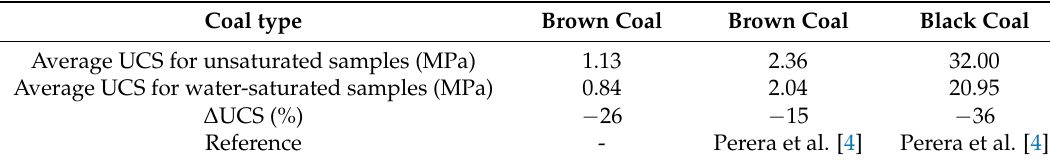
Table 6. Comparison of UCS values in present study and Perera et al.